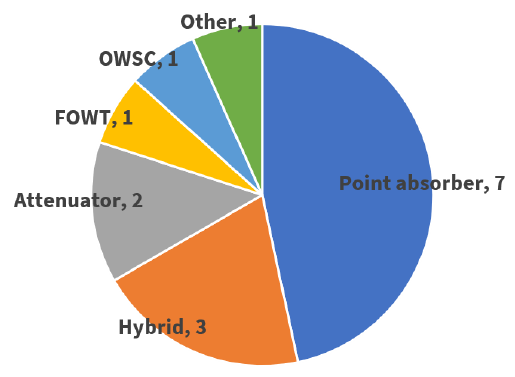
Fig. 3. Overview of novel device types studied using